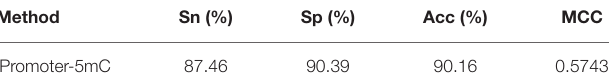
TABLE 2 | The results obtained by 5-fold cross validation on the training dataset S 1 .